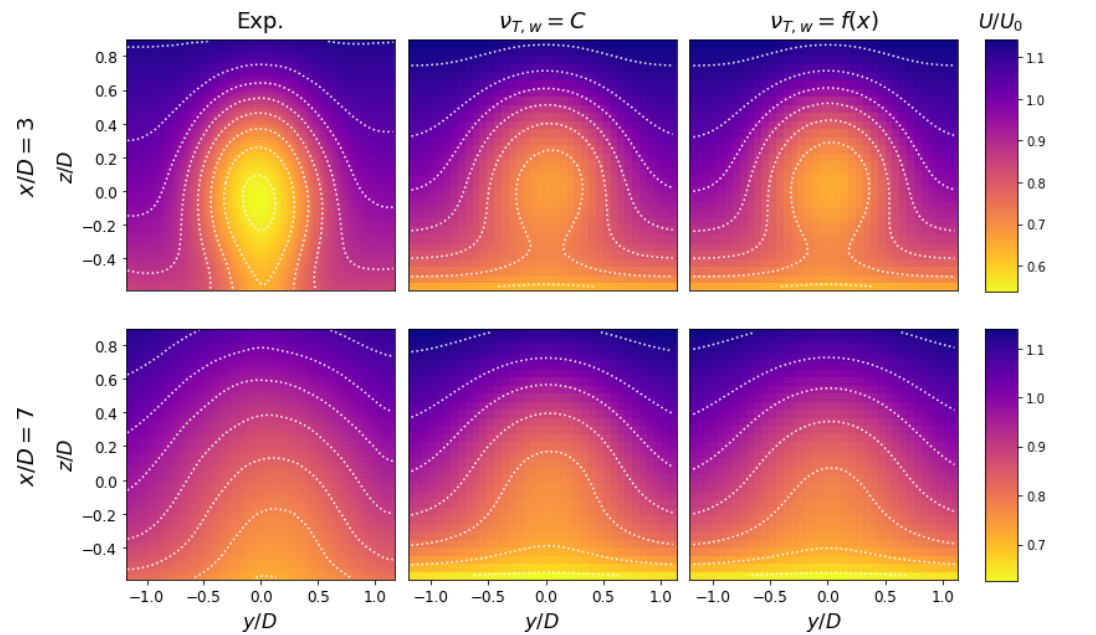
Figure 15. Contours of streamwise velocity in y – z planes for the aligned scaled model turbine. Here both formulations miss the near-wake velocity deficit but recreate the velocity profile at x/D = 7. Despite scaling the boundary layer height in FLORIS, the gradient produced by the mirror condition in the curled wake model is visible at x/D =